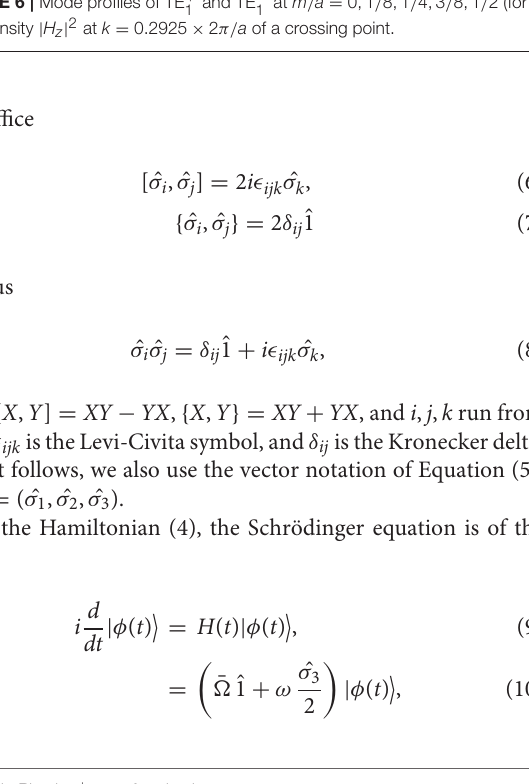
0,1 / 8,1 / 4,3 / 8,1 / 2 (for odd and even modes). (A) Field profile of the real part of H z at k =